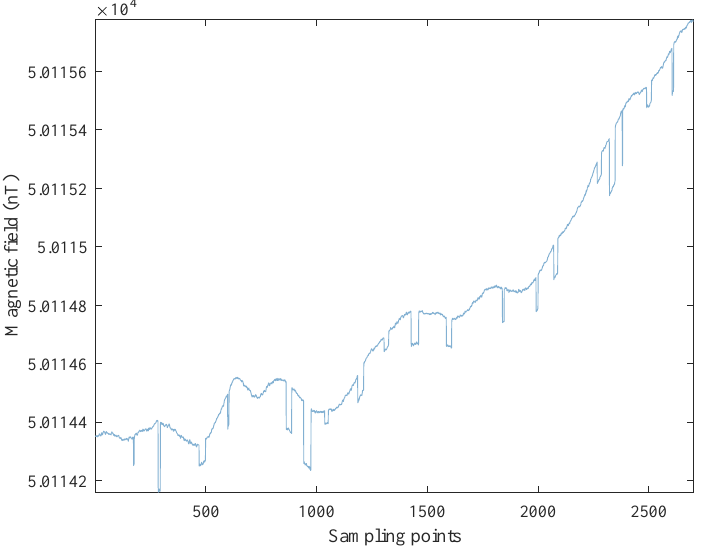
Figure 5. A segment of the semi-real